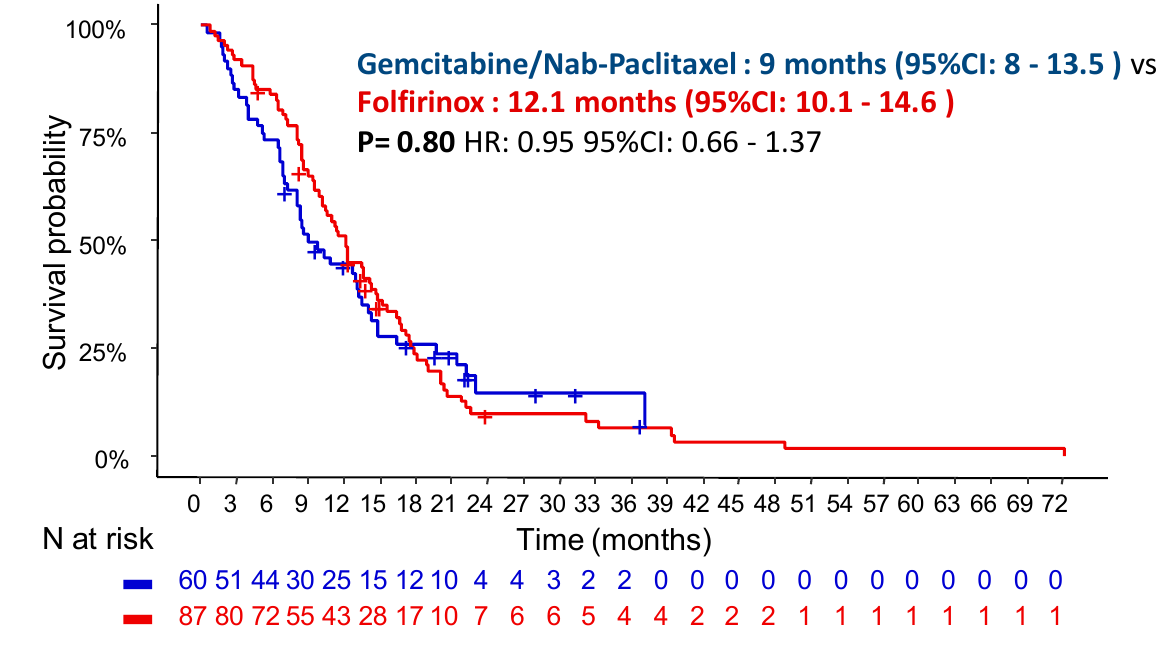
Figure 1. Progression-free survival depending on the chemotherapy regimen in patients with locally advanced pancreatic cancer.